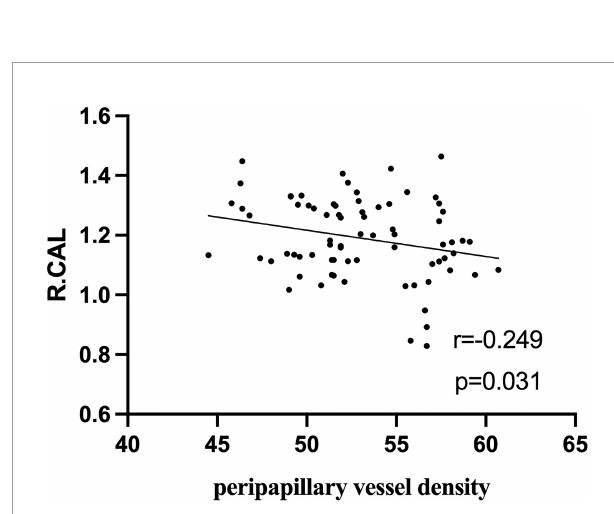
FIGURE 6 | In active TAO group, the fALFF values in R.CAL were negatively correlated with peripapillary vessel density (r = -0.249, p =